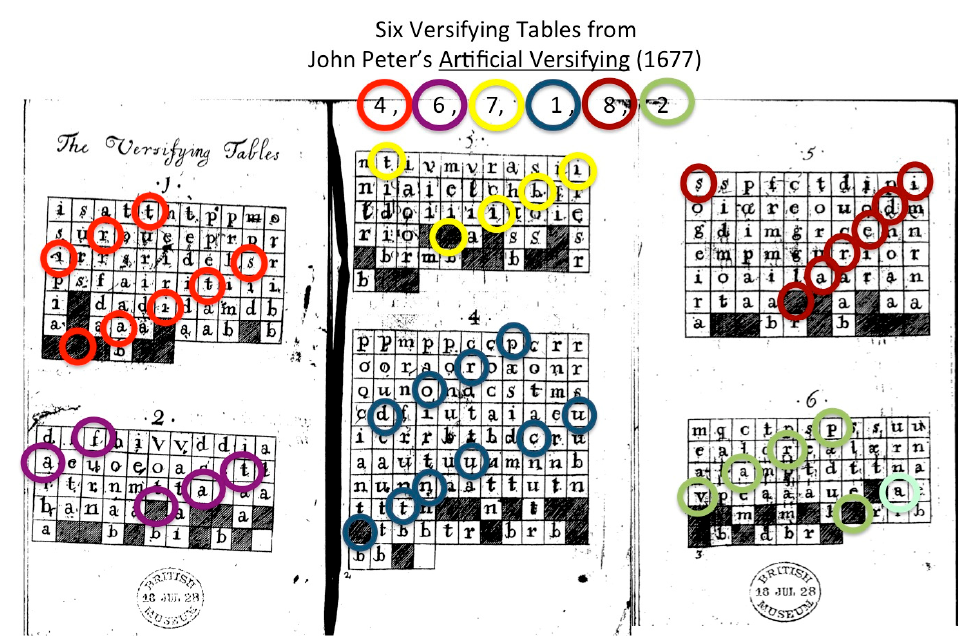
Figure 6. One example of John Peter’s versifying tables in use. Applying the six digits 4, 6, 7, 1, 8, 2 to the six tables according to Peter’s guidelines, a user can generate six Latin words that will form one line of hexameter verse ( Artificial Versifying , John Sims, 1677).